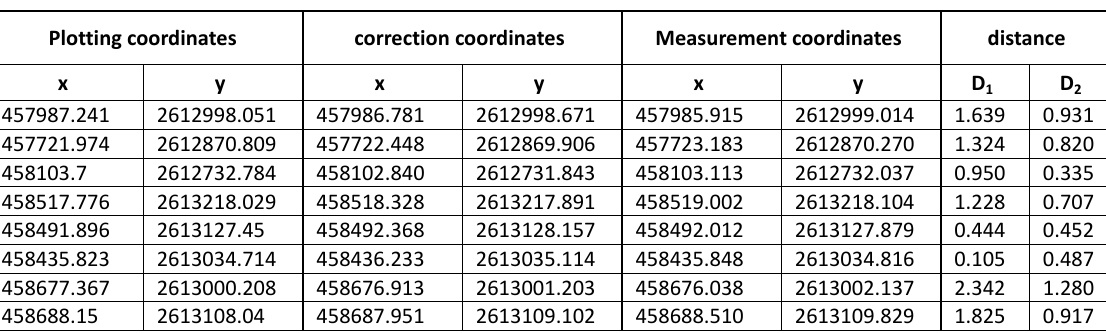
Table2: Some of the nodes coordinate notes：(1) The D1 in table means the distance between plotting point and the corresponding measuring point. (2)The D2 in table means the distance between correction point and the corresponding measuring